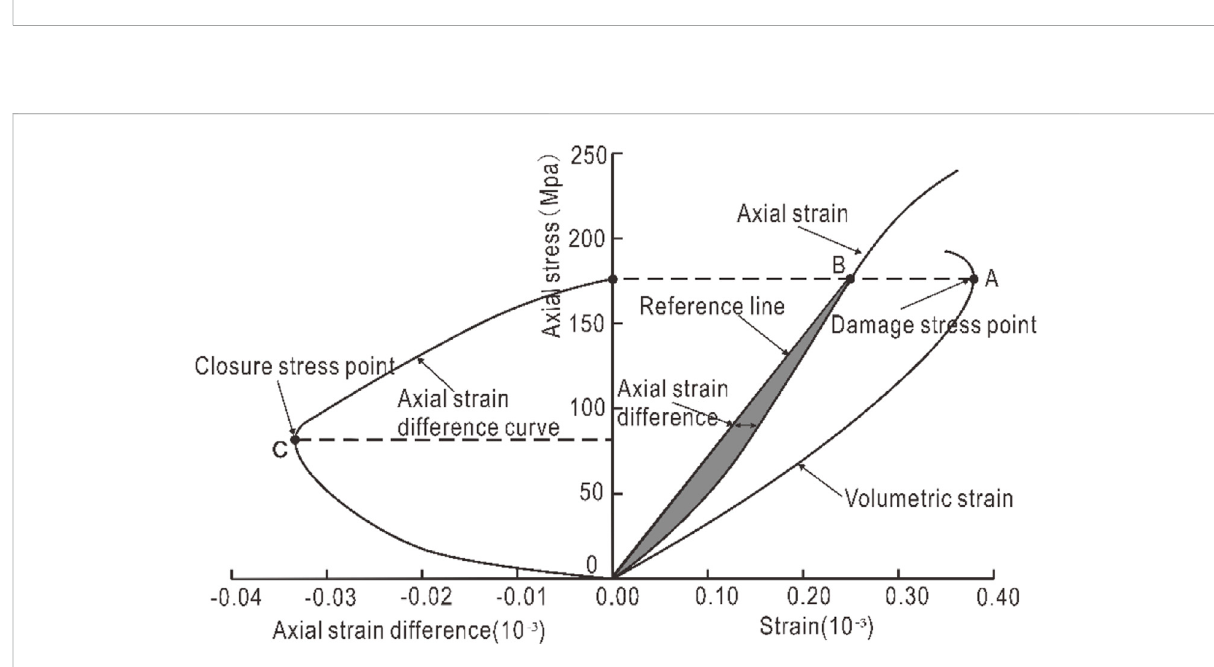
FIGURE 5 Schematic diagram of axial strain response method (Peng et al.,